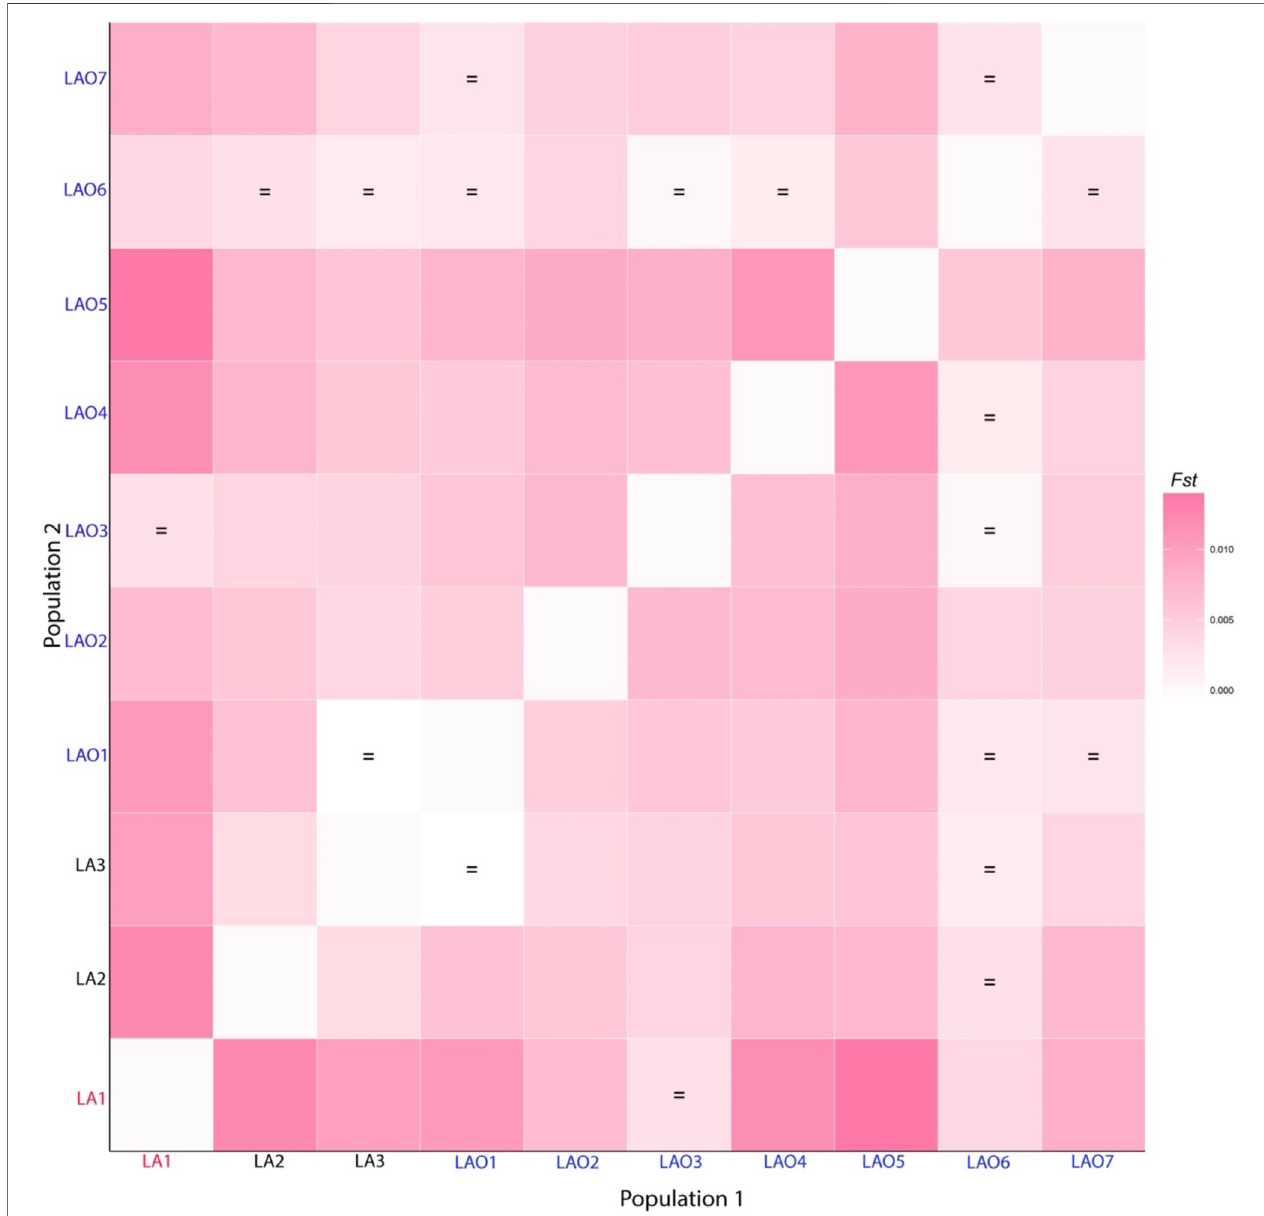
FIGURE 2 | Heat plot of F st values between 10 populations from Laos and Thailand. Population names are color-coded as red, black and blue representing AA- speaking Laotian, TK-speaking Laotians and Lao Isan, respectively. The “ = ” symbol indicates F st values that are not signi fi cantly different from zero ( p > 0.05).